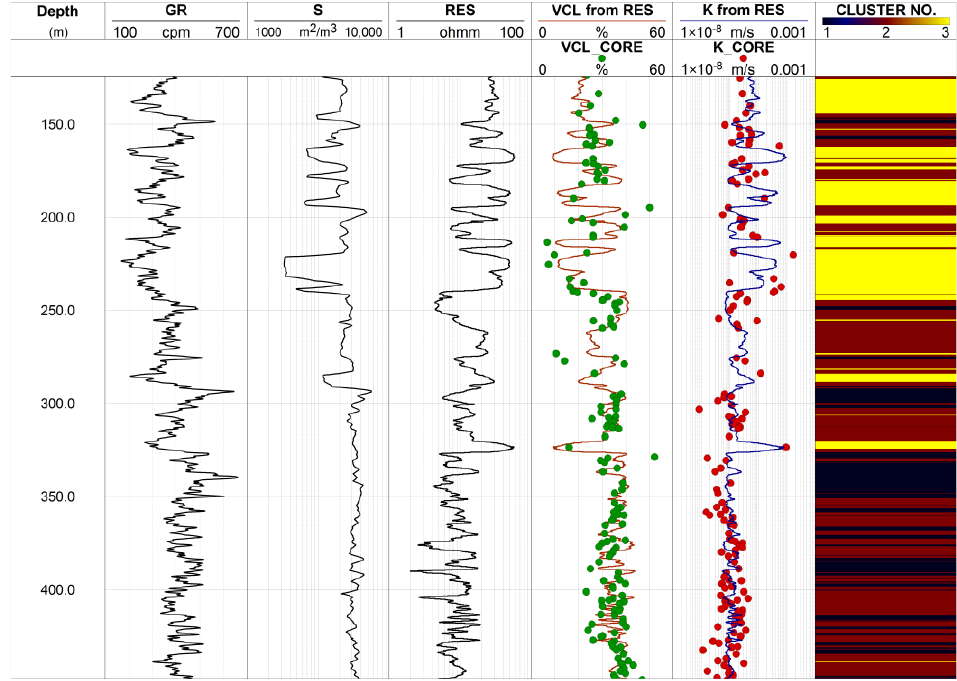
Figure 14. Result of multivariate statistical analysis of wireline logs in Baktalórántháza-1 well in Baktalórántháza-1 well, northeast Hungary.